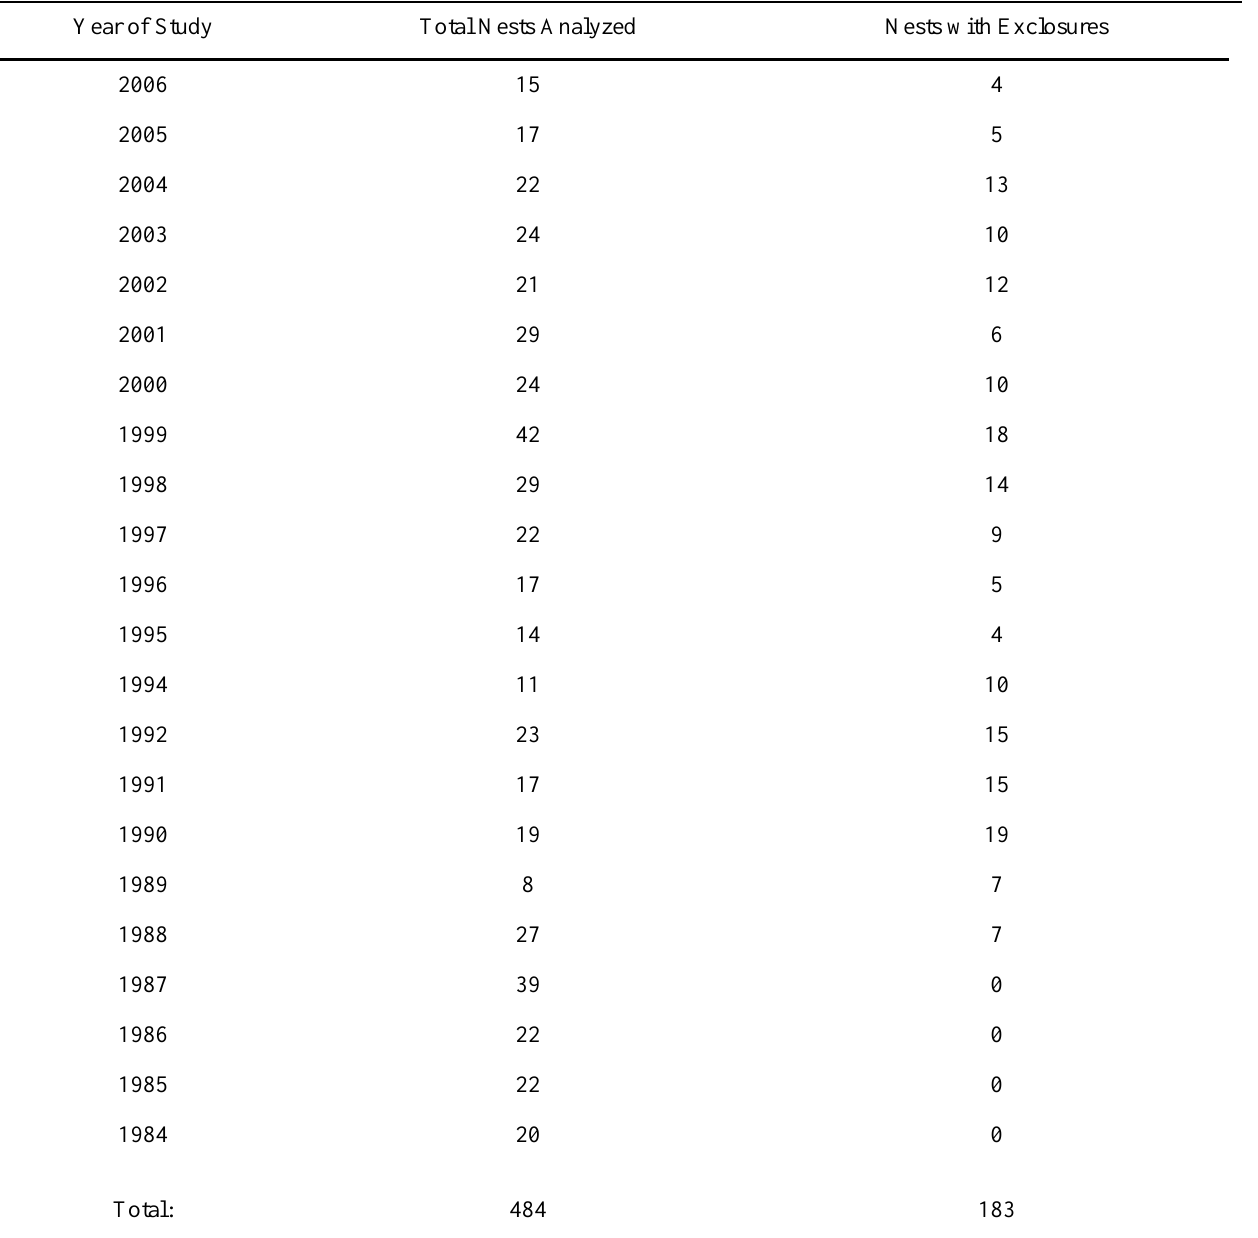
Table 1. Total number of nests analyzed and number of exclosed nests in each year over a 22 year period. Year of Study Total Nests Analyzed Nests with